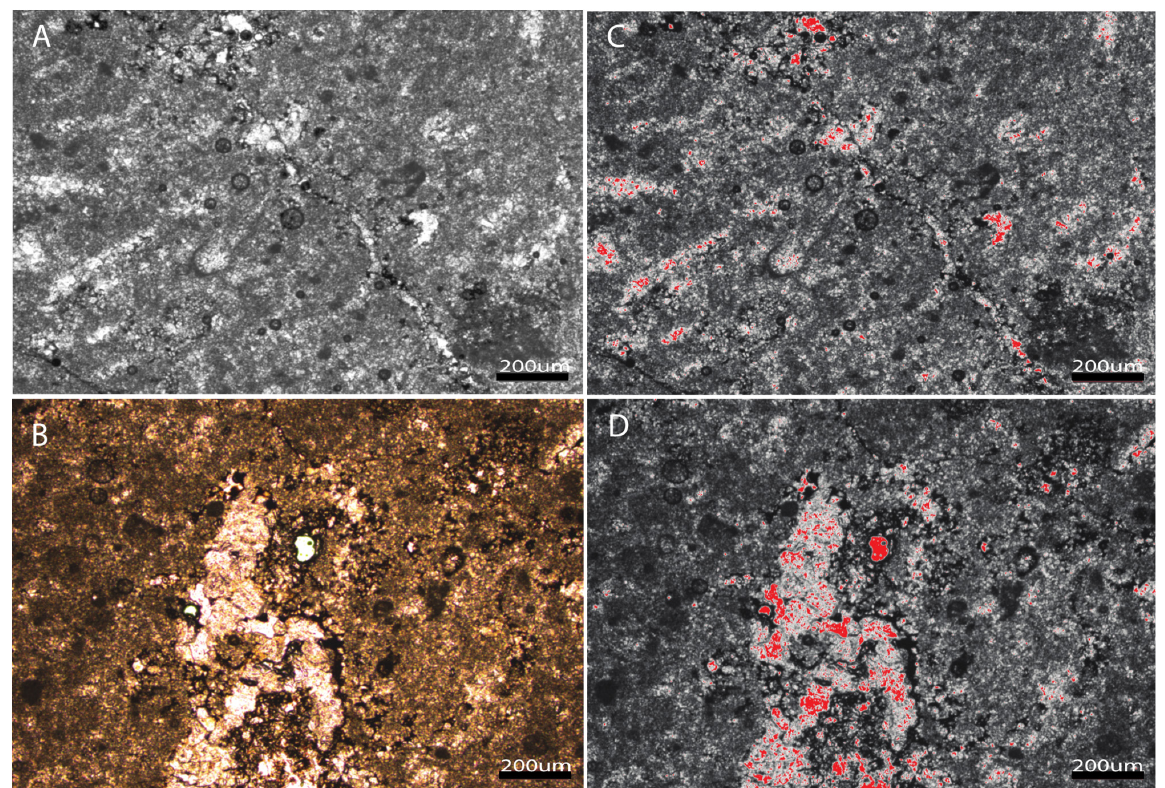
Figure 9. Microphotographs ( A ) of early diagenesis microfacies before analysis, ( B ) after analysis. ( C ) Late diagenesis microfa cies before analysis, ( D ) after analysis. The red contrast shows pore spaces.